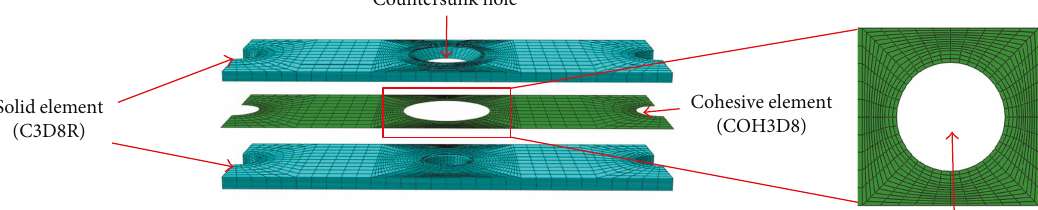
Figure 4: The structure of the composite layer and interface.